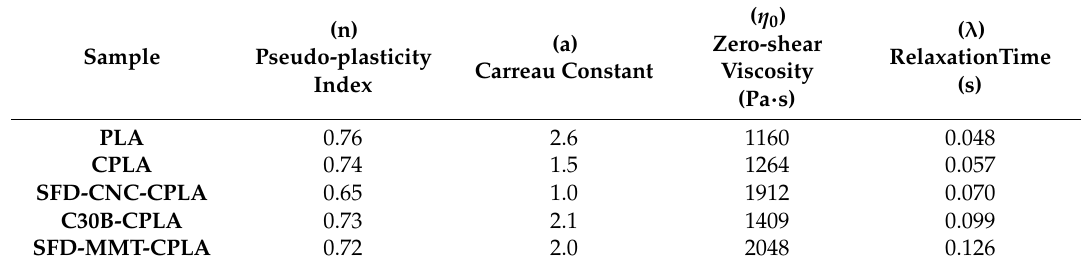
Table 2. Carreau–Yasuda model’s parameters for PLA, CPLA and corresponding nanocomposites.